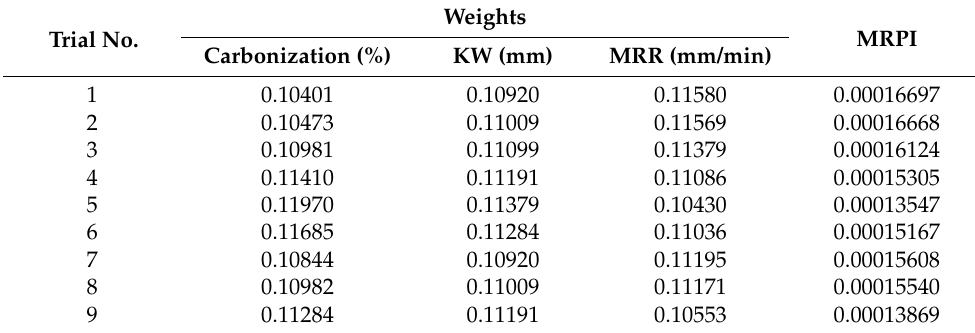
Table 4. Calculated values for weight and MRPI.